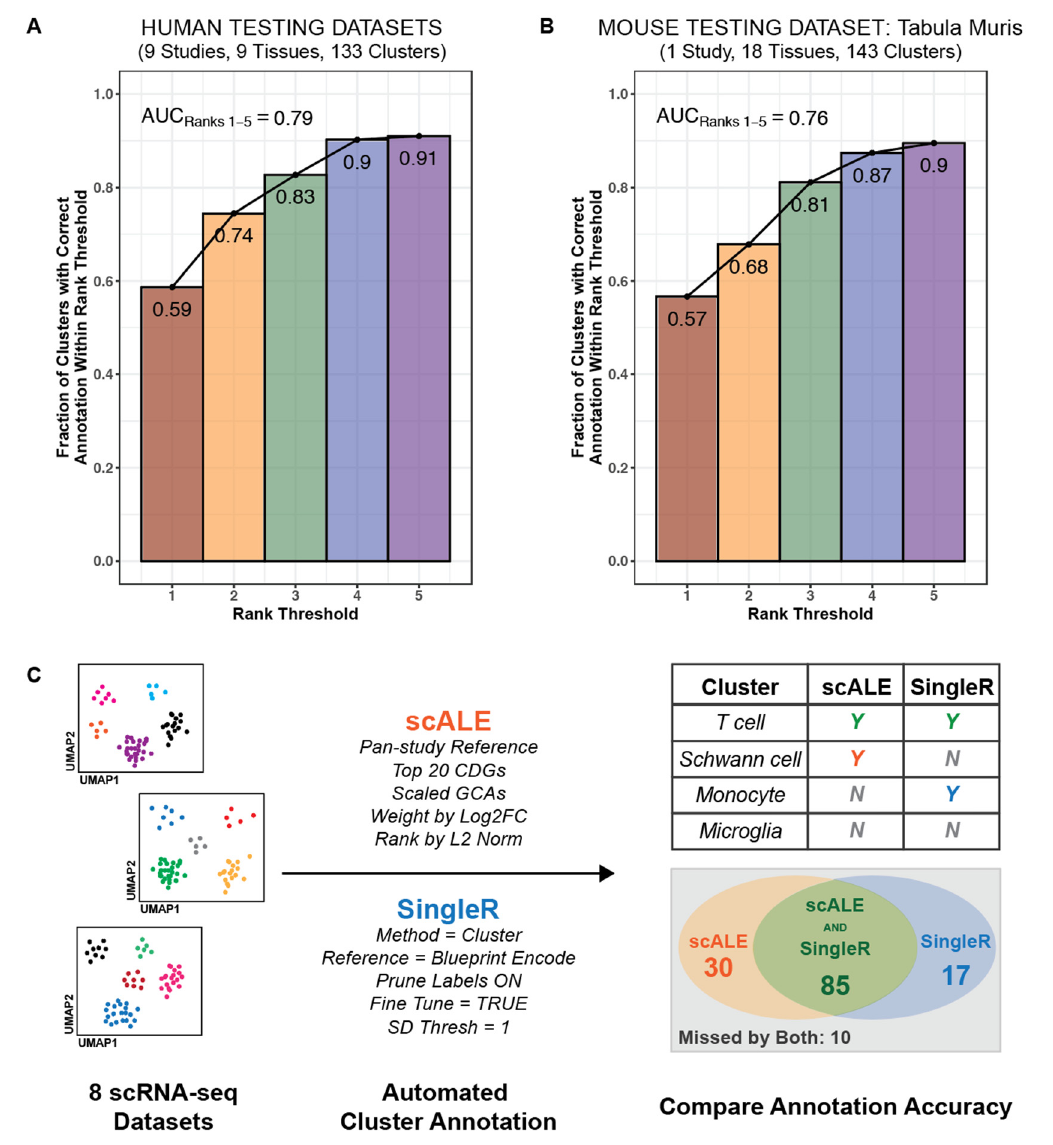
Figure 6. Application of scALE to testing datasets and comparison of performance with SingleR. ( A ) Using the previously optimized settings, scALE was applied to annotate 133 clusters from 9 “test” (i.e., previously unseen) studies [71–79]. ( B ) scALE was also applied to annotate 143 clusters from the murine scRNA-seq tissue atlas dataset, Tabula Muris [80]. ( C ) As a benchmark, we compared the accuracy of annotations from scALE to those obtained from SingleR [6] for 142 clusters from ten human studies [25–27,34–40]. scALE was implemented with the previously optimized parameters, and SingleR was implemented using the listed parameters. Manual review was performed to determine whether each cluster was labeled correctly by scALE only ( n = 30), SingleR only ( n = 17), both scALE and SingleR ( n = 85), or neither ( n =